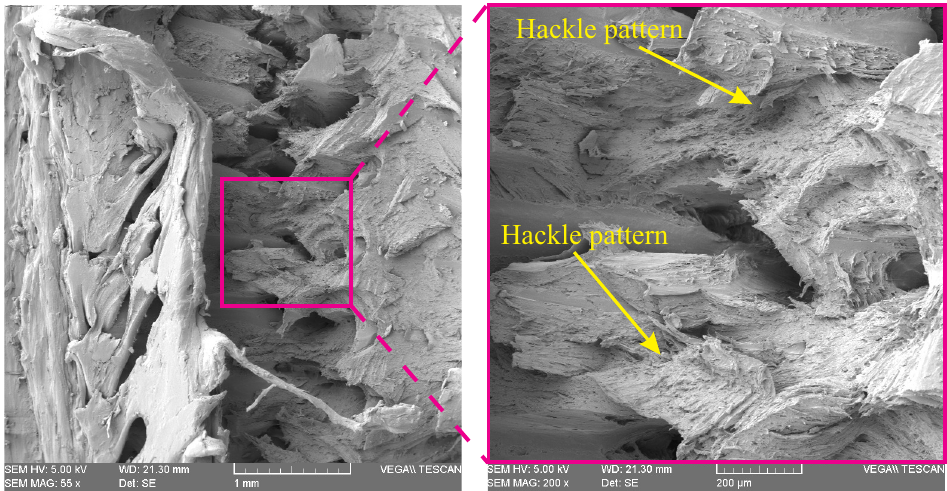
Figure 11. SEM images of point 1 of a 3D-printed PLA specimen with hole diameter of 3